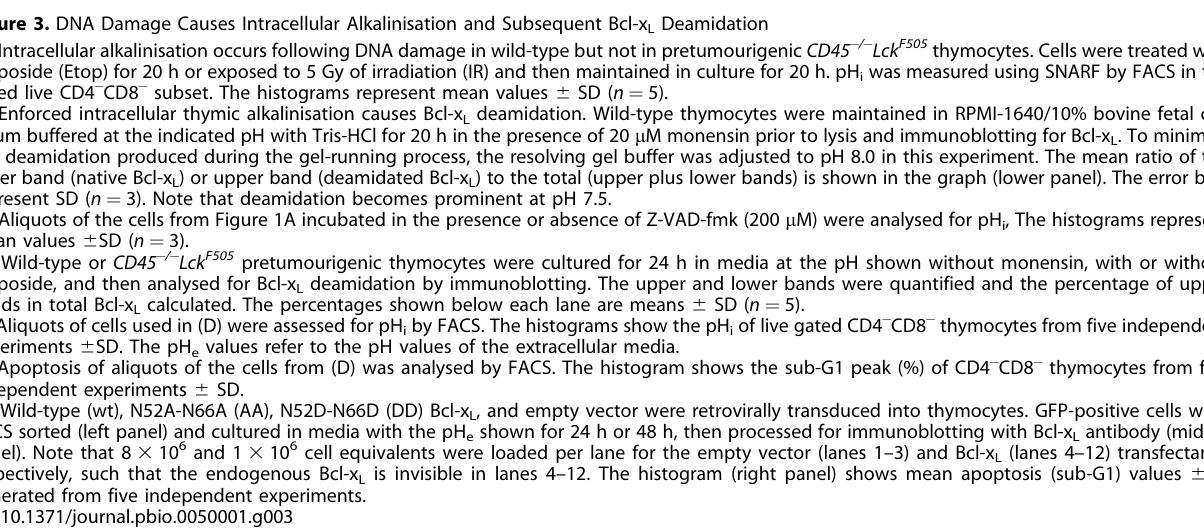
Figure 3. DNA Damage Causes Intracellular Alkalinisation and Subsequent Bcl-x L Deamidation (A) Intracellular alkalinisation occurs following DNA damage in wild-type but not in pretumourigenic CD45 (cid:1) / (cid:1) Lck F505 thymocytes. Cells were treated with etoposide (Etop) for 20 h or exposed to 5 Gy of irradiation (IR) and then maintained in culture for 20 h. pH i was measured using SNARF by FACS in the gated live CD4 (cid:1) CD8 (cid:1) subset. The histograms represent mean values 6 SD ( n ¼ 5). (B) Enforced intracellular thymic alkalinisation causes Bcl-x L deamidation. Wild-type thymocytes were maintained in RPMI-1640/10% bovine fetal calf serum buffered at the indicated pH with Tris-HCl for 20 h in the presence of 20 l M monensin prior to lysis and immunoblotting for Bcl-x L . To minimize any deamidation produced during the gel-running process, the resolving gel buffer was adjusted to pH 8.0 in this experiment. The mean ratio of the lower band (native Bcl-x L ) or upper band (deamidated Bcl-x L ) to the total (upper plus lower bands) is shown in the graph (lower panel). The error bars represent SD ( n ¼ 3). Note that deamidation becomes prominent at pH 7.5. (C) Aliquots of the cells from Figure 1A incubated in the presence or absence of Z-VAD-fmk (200 l M) were analysed for pH i , The histograms represent mean values 6 SD ( n ¼ 3). (D) Wild-type or CD45 (cid:1) / (cid:1) Lck F505 pretumourigenic thymocytes were cultured for 24 h in media at the pH shown without monensin, with or without etoposide, and then analysed for Bcl-x L deamidation by immunoblotting. The upper and lower bands were quantified and the percentage of upper bands in total Bcl-x L calculated. The percentages shown below each lane are means 6 SD ( n ¼ 5). (E) Aliquots of cells used in (D) were assessed for pH i by FACS. The histograms show the pH i of live gated CD4 (cid:1) CD8 (cid:1) thymocytes from five independent experiments 6 SD. The pH e values refer to the pH values of the extracellular media. (F) Apoptosis of aliquots of the cells from (D) was analysed by FACS. The histogram shows the sub-G1 peak (%) of CD4 (cid:1) CD8 (cid:1) thymocytes from five independent experiments 6 SD. (G) Wild-type (wt), N52A-N66A (AA), N52D-N66D (DD) Bcl-x L , and empty vector were retrovirally transduced into thymocytes. GFP-positive cells were FACS sorted (left panel) and cultured in media with the pH e shown for 24 h or 48 h, then processed for immunoblotting with Bcl-x L antibody (middle panel). Note that 8 3 10 6 and 1 3 10 6 cell equivalents were loaded per lane for the empty vector (lanes 1–3) and Bcl-x L (lanes 4–12) transfectants, respectively, such that the endogenous Bcl-x L is invisible in lanes 4–12. The histogram (right panel) shows mean apoptosis (sub-G1) values 6 SD generated from five independent experiments.